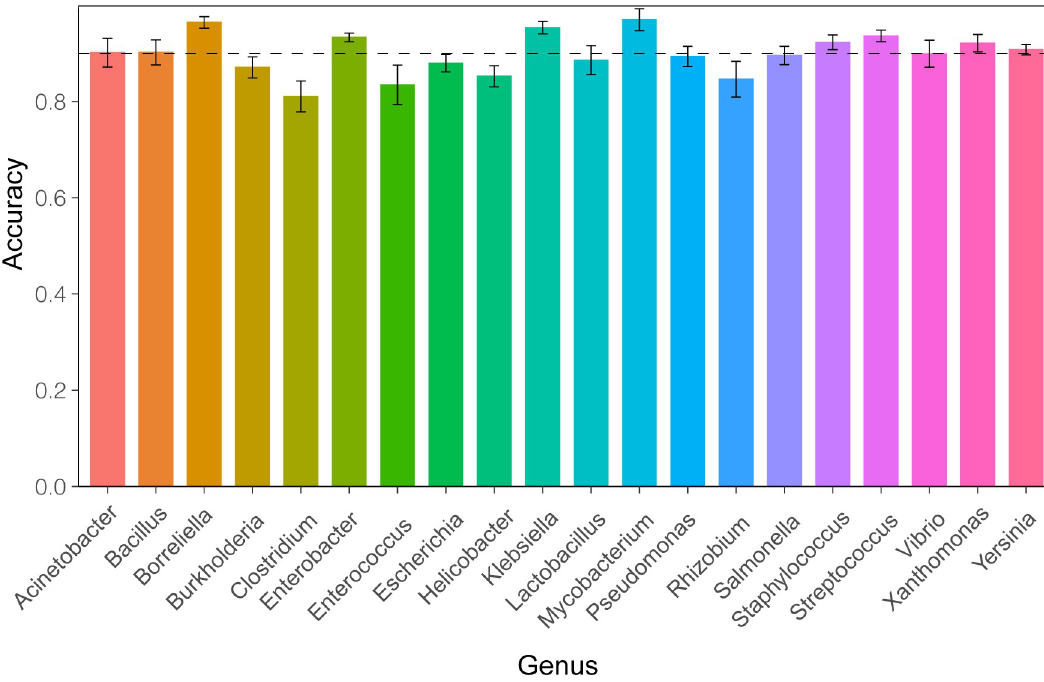
Fig 4. Classification accuracy for the top 20 genera in the test set. The dotted line indicates accuracy of 0.9. Error bars are the standard deviation from the result of the 10-fold cross